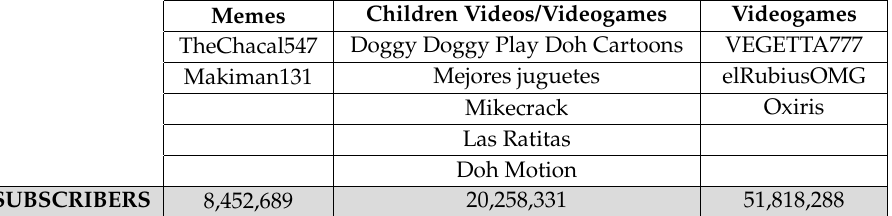
Table 3. Total number of subscribers per genre in the top 10 Spanish YouTubers (5 May